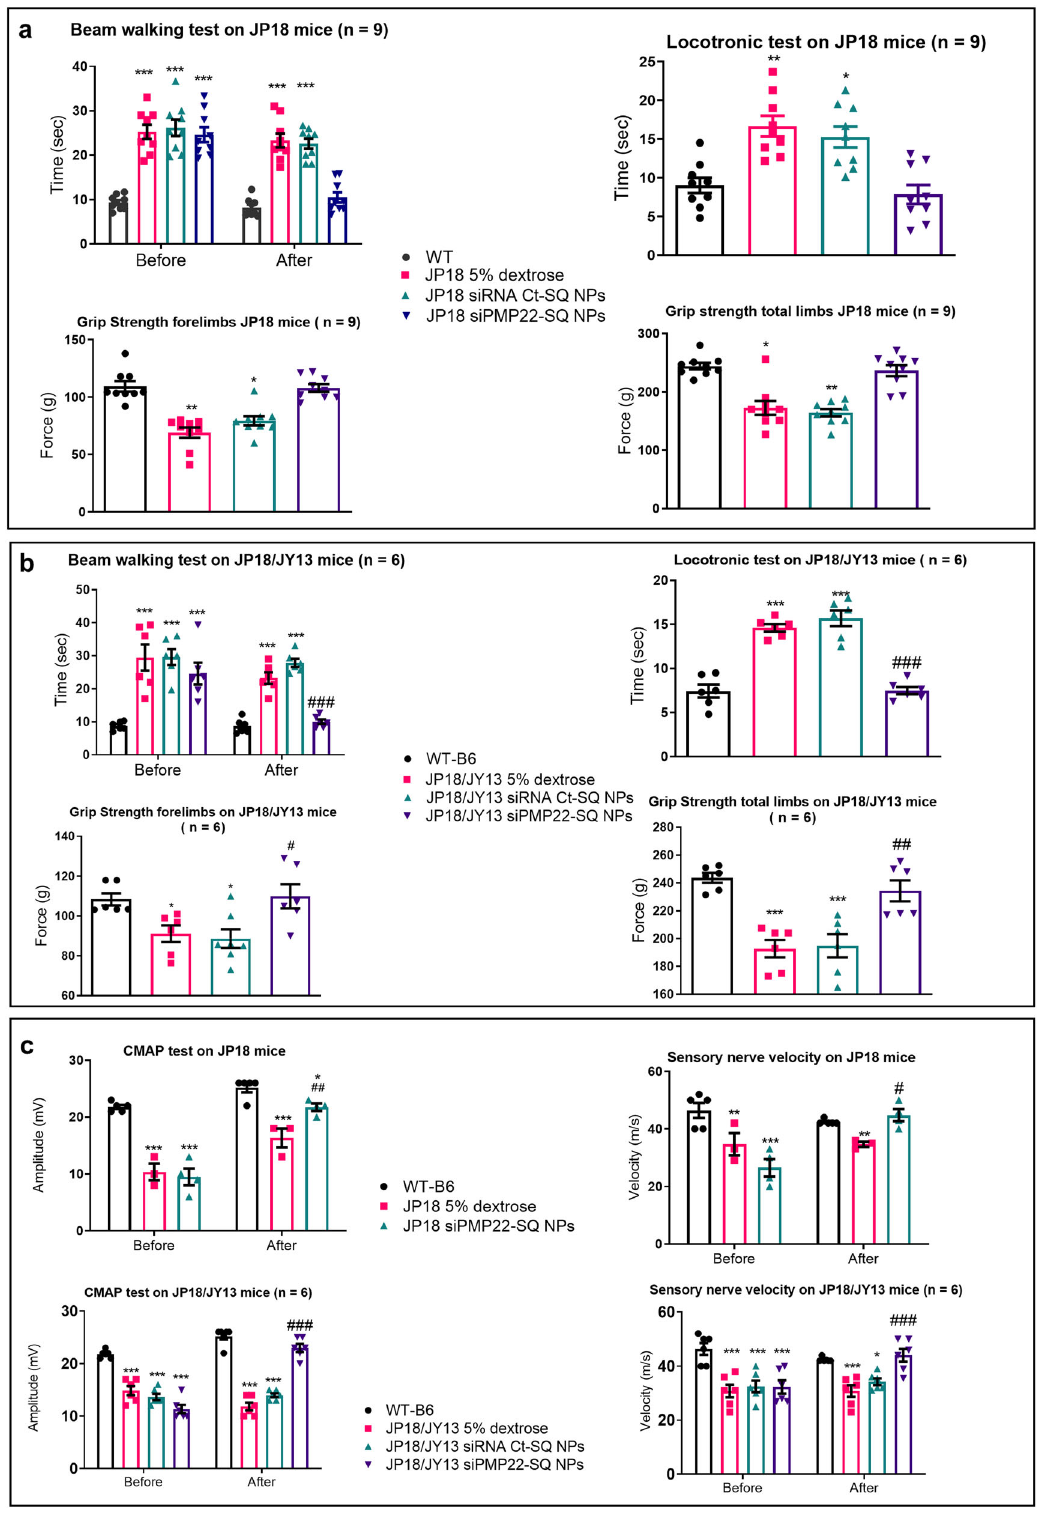
precursor of cholesterol 46 , the levels of different forms of plasma cholesterol were studied and we found no signi fi cant change in their levels between the treated groups (Supplementary Table 3). Observation on TEM images showed no toxicity of the siRNA-SQ NPs on the sciatic nerve represented by the absence of Schwann cell damage, no alterations in the number of mitochondria and no modi fi cations in the intracellular